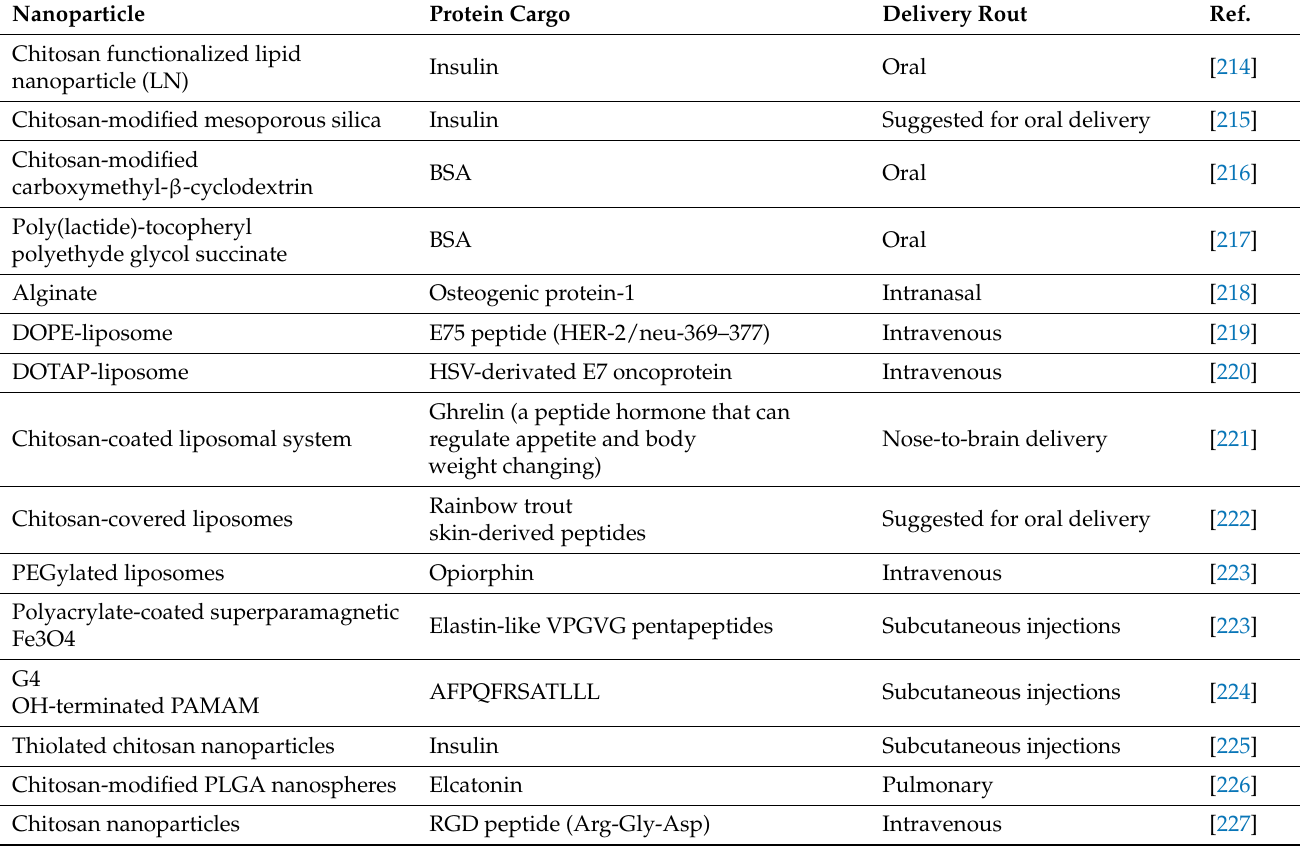
Table 5. Examples of those nanoparticles have been used to stabilize proteins and